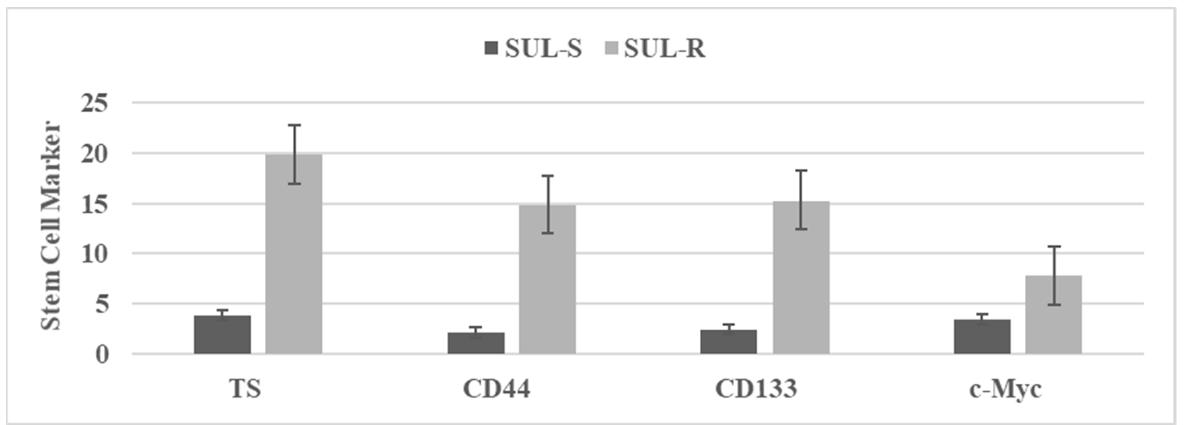
Figure 2. The status of stem cell markers in sulindac resistant (SUL-R) 850 MIN COL phenotype. Figure 2. TS: Tumor spheroid number determined at day 14 after seeding 100 cells. Mean ± SD, n = 3 per treatment group. CD44, CD133, c-Myc. RFU determined at day four after seeding 1.0 × 10 5 cells. Data presented as mean ± SD, n = 3 per treatment group, and analyzed by paired Student’s t -test. SUL-S, sulindac sensitive; SUL-R, sulindac resistant; CD, cluster of differentiation; c-Myc, cellular Myc; RFU, relative fluorescent